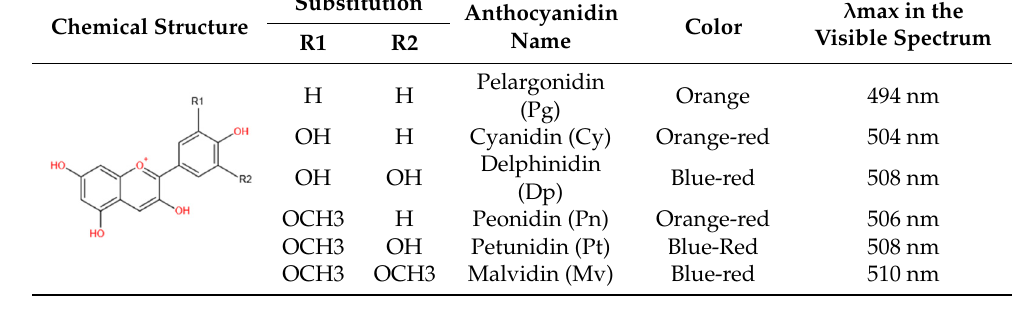
Table 1. Chemical structure and physical characters of the six common anthocyanindins.